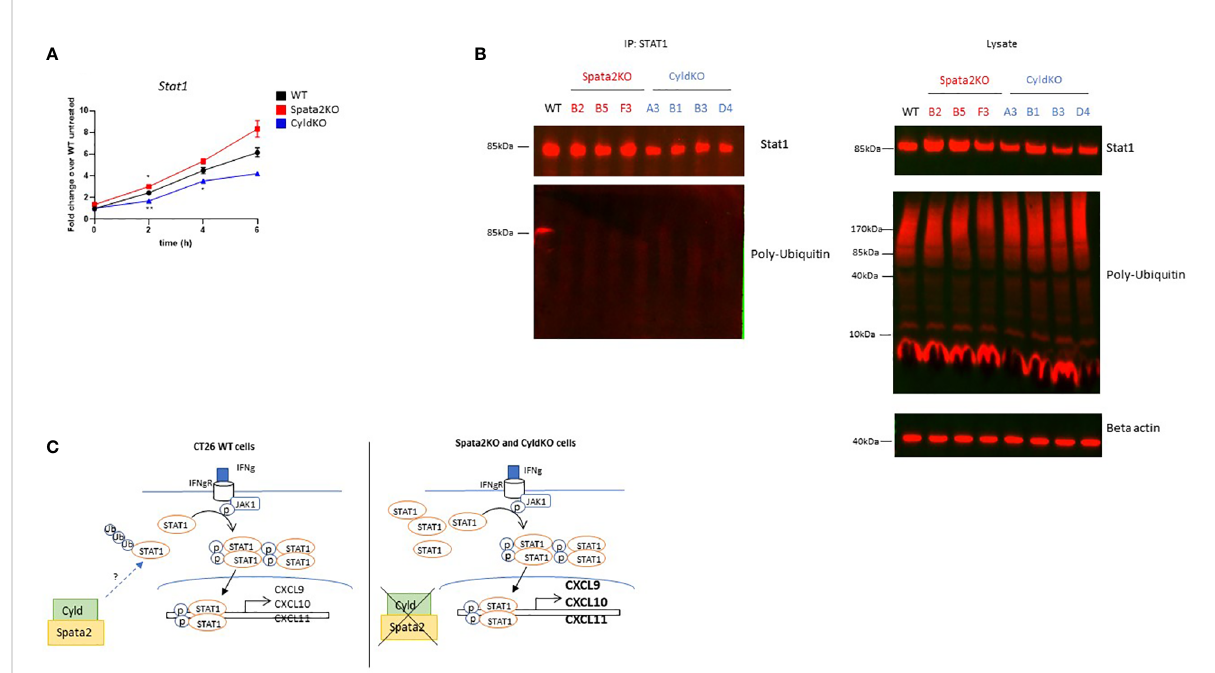
FIGURE 4 Decreased poly-ubiquitination of STAT1 in SPATA2 - and CYLD -de fi cient CT26 cells. (A) Cells were stimulated with IFN- g for 0, 2, 4 and 6 hours as indicated. Stat1 gene expression was measured by real-time quantitative PCR (RT-qPCR). Fold change over untreated WT cells represented. Results are representative of 1 out of 2 independent experiments. Mean ± SEM. * p<0.05, ** p<0.01 (Unpaired Student ’ s t test for each timepoint) (B) Immunoprecipitation of STAT1 in unstimulated cells followed by Western blot of indicated protein partners (left). Input controls are shown in the right panel. Results are representative of 2 independent experiments. (C) Proposed mechanism of action by which SPATA2 and CYLD regulate IFN- g -STAT1-CXCL10 axis in CRC